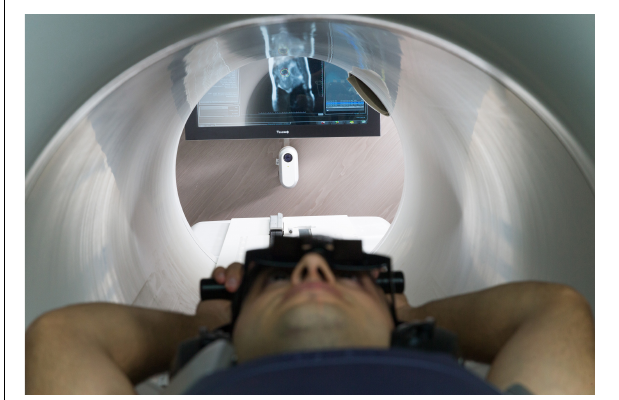
FIGURE 1 | Patient set-up during magnetic resonance-guided radiation therapy.